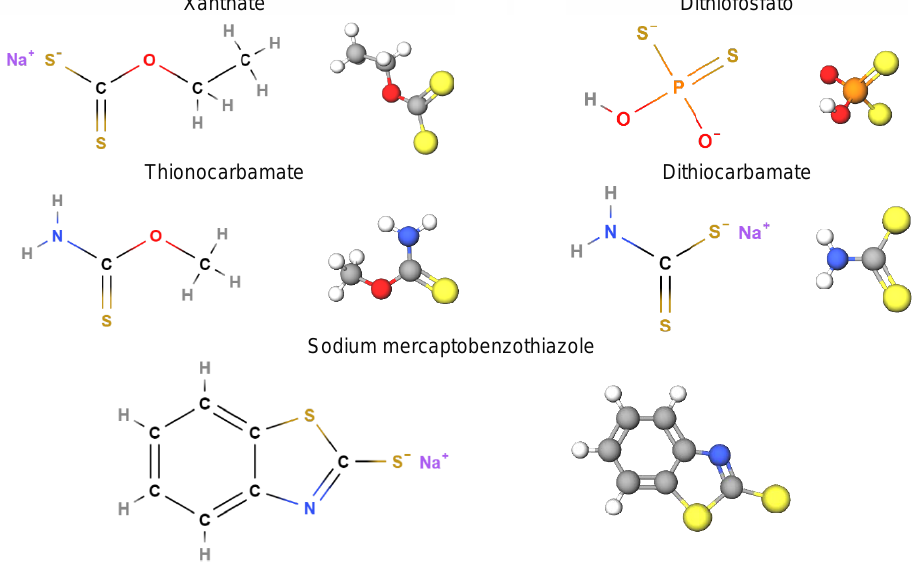
Figure 8. Examples of typical thiol collectors.